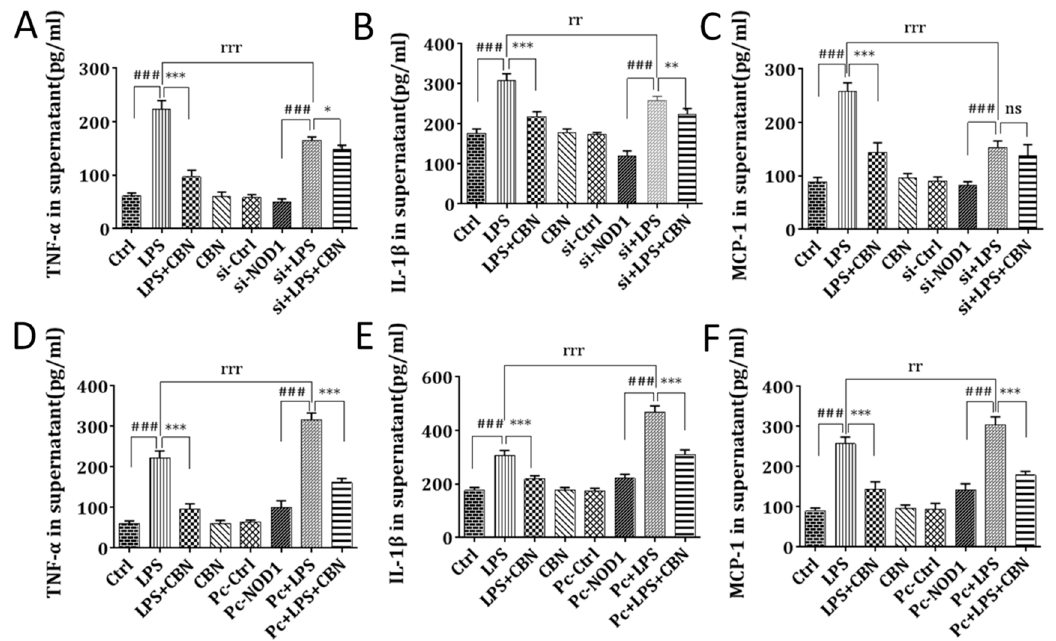
Figure 4. Effects of CBN on inflammatory cytokine expression in the supernatants of LPS-stimulated THP-1 cells. ( A – C ) Protein expression after NOD1 siRNA transfection in THP-1 cells: ( A ) TNF- α , ( B ) IL-1 β , and ( C ) MCP-1. ( D – F ) Protein expression after pcDNA-NOD1 transfection in THP-1 cells: ( D ) TNF- α , ( E ) IL-1 β , and ( F ) MCP-1. ### P < 0.001, LPS group versus control group; * P < 0.05, drug group versus LPS group; ** P < 0.01, drug group versus LPS group; *** P < 0.001, drug group versus LPS group; rr P < 0.01 (si + LPS/Pc + LPS) versus LPS group; rrr P < 0.001 (si + LPS/Pc + LPS) versus LPS group; ns indicates no significance between the two groups. The results shown are representative of three independent experiments with similar results. Data are expressed as means ± SD.